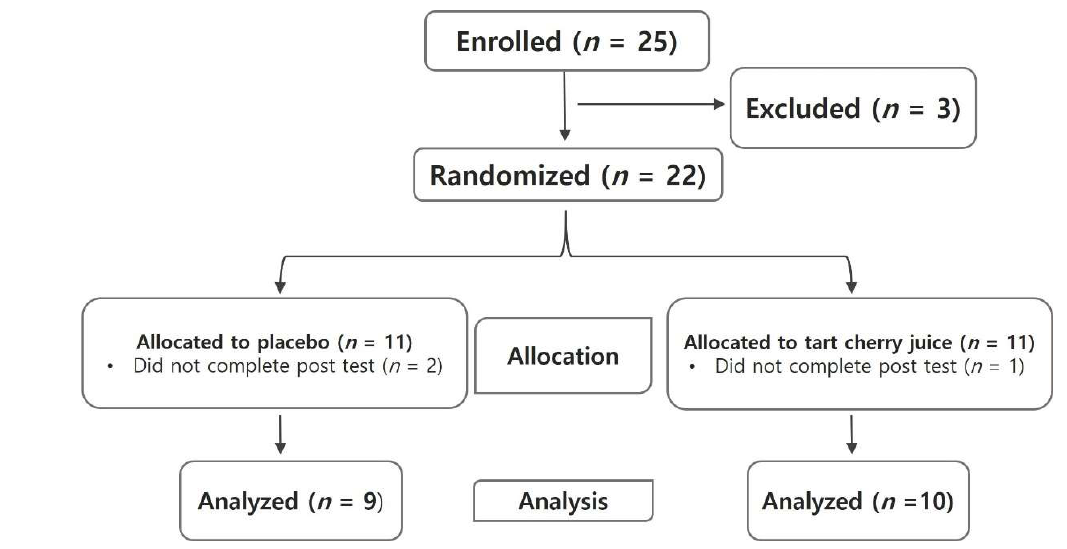
Figure 1. Flow chart of the study.